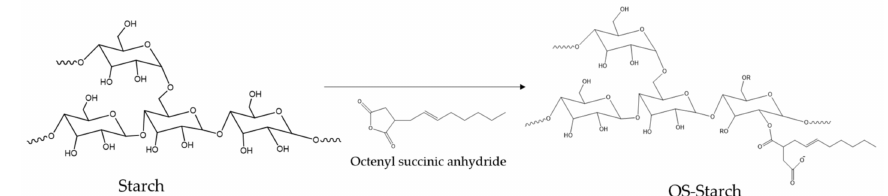
Figure 8. Schematic illustration of the reaction of OSA-starch